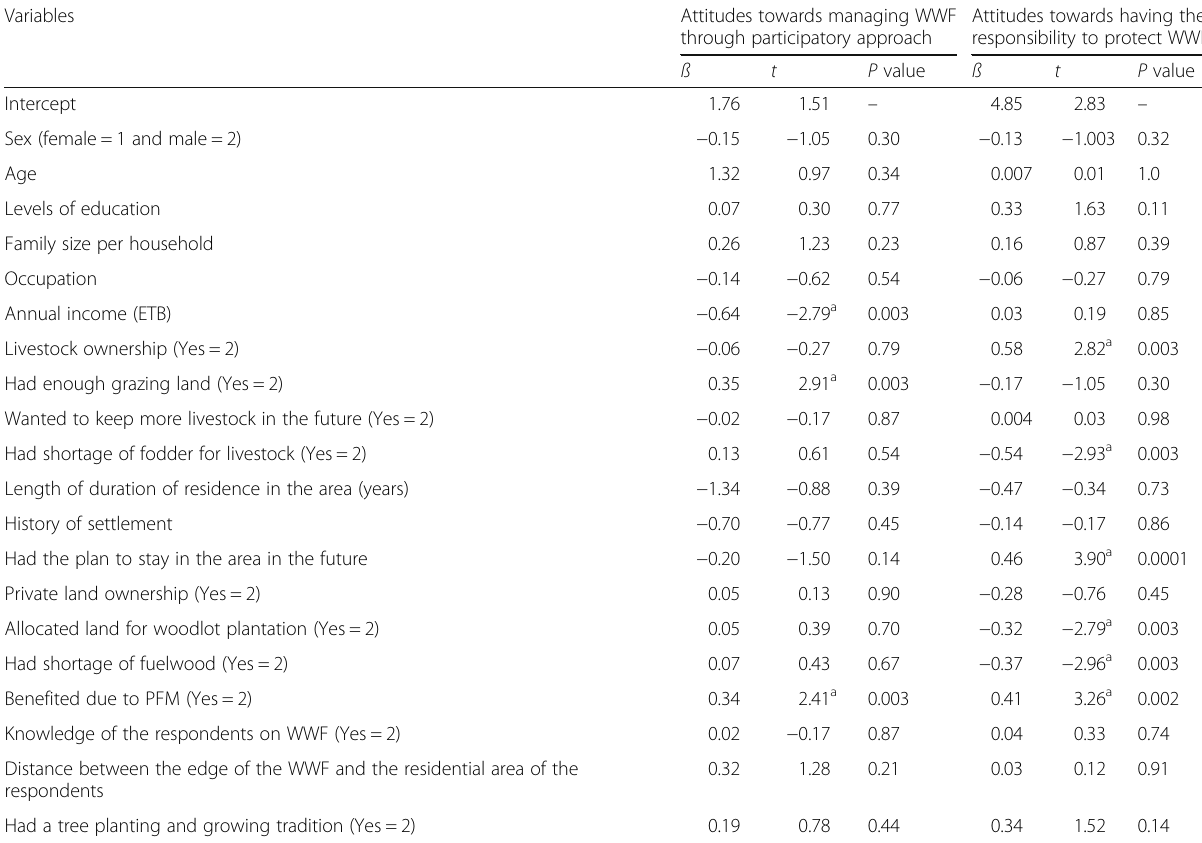
Table 5 Multiple linear regression model (standardized coefficients were reported) to predict the attitudes of local people towards managing forests through participatory approach ( R 2 = 0.423 (Adj. R 2 = 0.16), df = 19; F = 1.579, overall P = 0.044), and having the responsibility to protect the WWF ( R 2 = 0.535 (Adj. R 2 = 0.32), df = 19; F = 2.475, overall P = 0.006). (+ = a positive change in